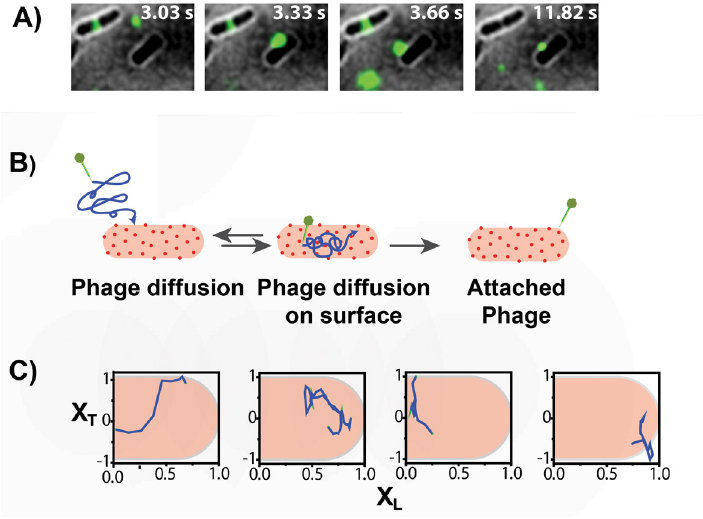
trajectories in each of the observed regimes, forming distinct groups with more than an order of magnitude separation in MSD values: off- cell diffusion trajectories (green), on- cell diffusion (red), and attachment (blue). Trajectories for both off -cell diffusion and on-cell diffusion yielded a log-log slope of ~1, indicative of normal diffusion. Viruses bound to the host showed either small, confined movement or no movement, with a 0.5–0 ) throughout the spatial slope range. ( F ) Di stributions of virus positions along the cell (X L focusing process. Error bars: mean ± SE. (i) Initial random point of encounter (top panel, 47 viral trajectories). (ii) Unbound viruses moving on the surface of the host (middle pane l, 138 viral trajectories). (iii) Distribution of final infection sites with a clear trend for polar localization (bottom panel, 59 viral trajectories). The area of all three distributions was normalized to facilitate comparison between the different distributions. Adopted and modified after